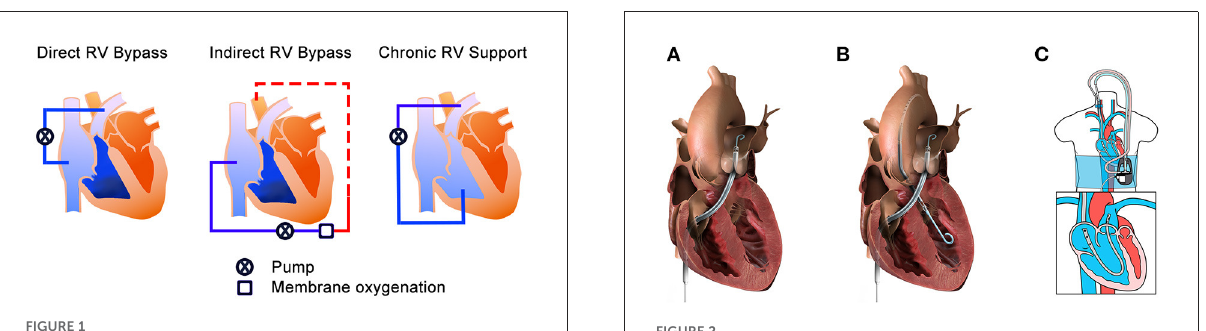
FIGURE2 Percutaneous mechanical circulatory support devices for RHF. (A) Impella RP (image from Abiomed media kit, used with permission). (B) BiPella (image from Abiomed media kit,